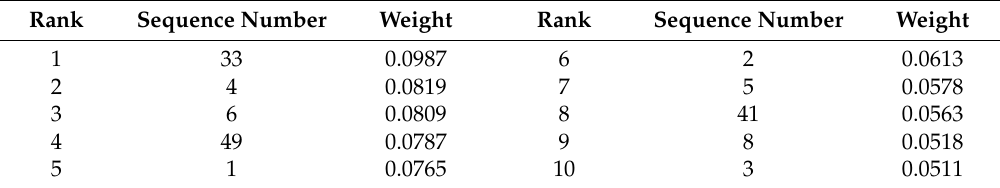
Table 7. Weights of the first 10 features in 2005.